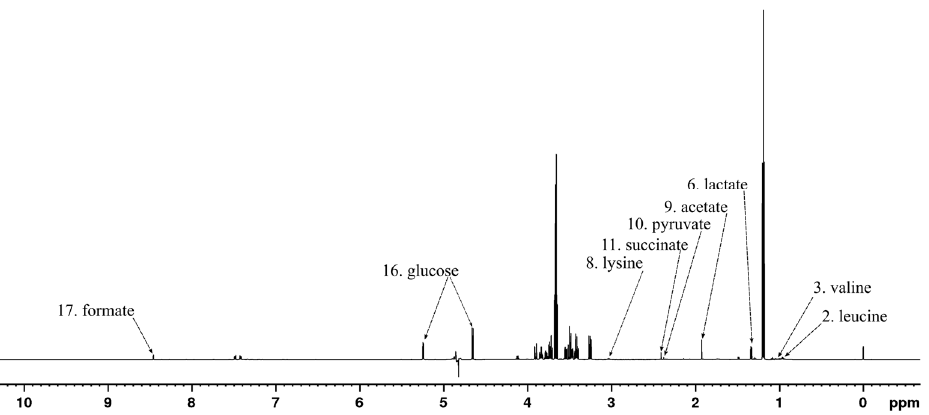
Figure 3. 1 H NMR spectrum of E . coli culture sample at the 0 h time point after treatment with rugosin D ( 6 ) with example signals of the significant metabolites labeled according to Table 1.